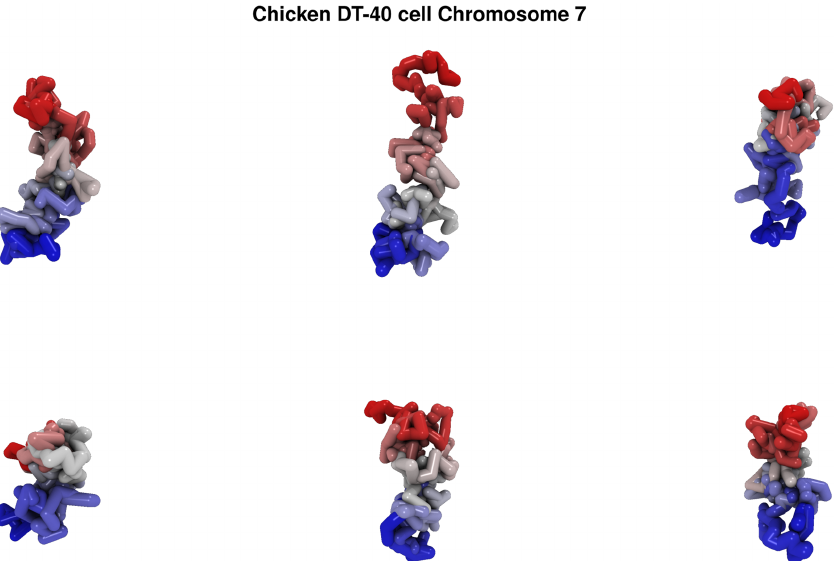
FIG. 18. Individual conformation for chromosome 7 for chicken DT-40 cell line. Six individual conformations are shown. Each individual conformation is generated randomly. The colors encode the genomic position of the loci. Red and blue represent the 5 0 and 3 0 ends,